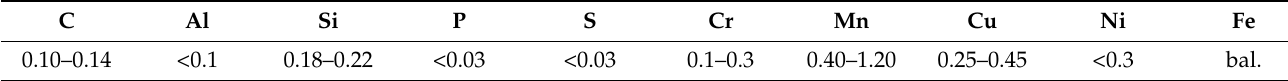
Table 1. Manufacturer-guaranteed steel